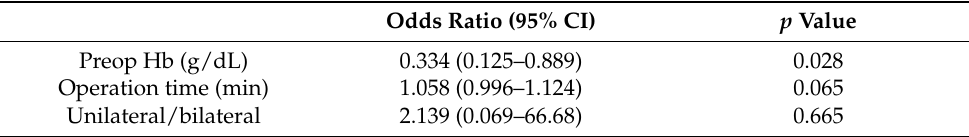
Table 7. Multivariate Analysis for postoperative anemia in pSS